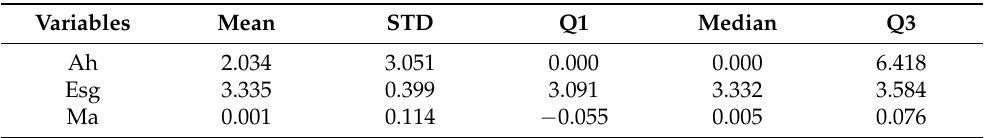
Table 2. Descriptive statistics.